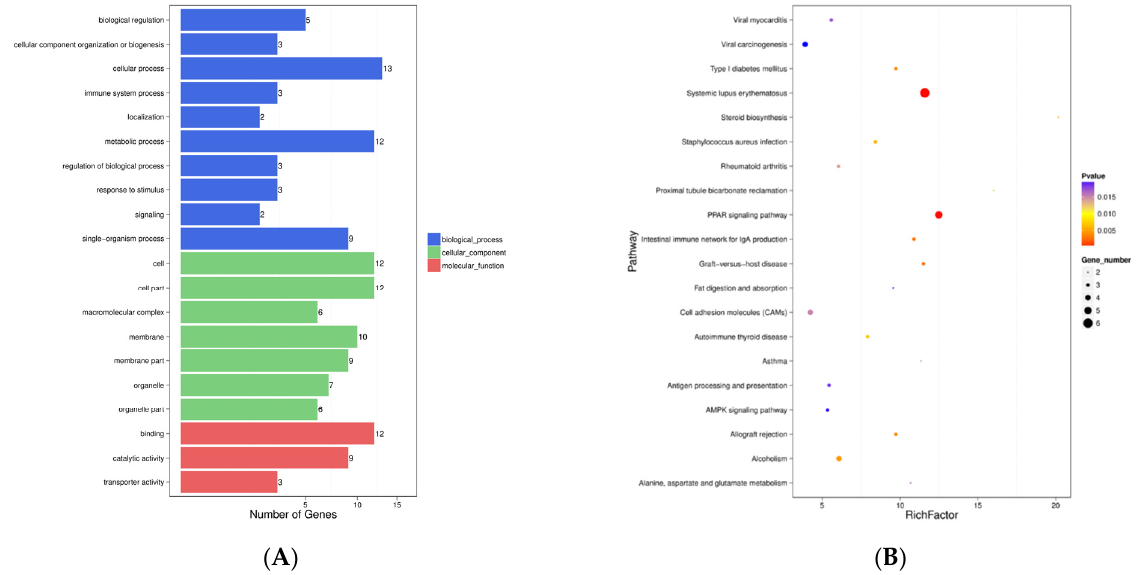
Figure 2. GO and KEGG enrichment analysis. ( A ) The GO terms of the enrichment analysis of the DEGs. Blue represents a biological process, green represents a cellular component, and red represents a molecular function. ( B ) The KEGG pathway enrichment analysis of the DEGs. The larger the circle area’s mean, the more differently expressed the gene number. The p -value represents a significant level ( p < 0.05).